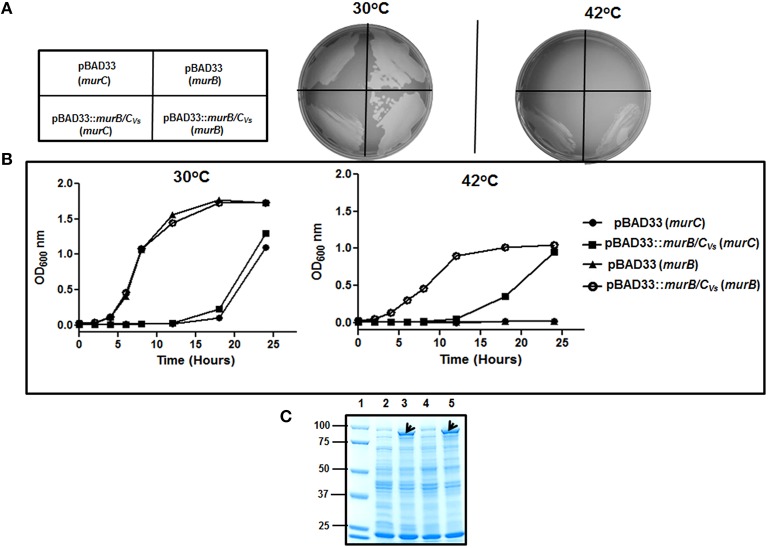
Functional complementation analysis of the E. coli murB and murC mutants. (A) Replica-plating experiment of the murC and murB mutants transformed with pBAD33 and pBAD33::murB/CVs grown at 30 and 42°C. (B) Analysis of the complementation experiment at 30 and 42°C in liquid culture assessing the growth phenotype by measurement of the optical density (OD) at 600 nm for a 24 h period. The growth experiments were done four times giving the similar growth profiles. The graphs in (B) represent one of those growth curves. (C) SDS-PAGE analysis of proteins from the complementation experiment to assess the expression of MurB/C in the mutant backgrounds. Lane (1), protein ladder (kDa). Lane (2), 10 μg of protein extract from the E. coli murC mutant harboring pBAD33 grown at 30°C. Lane (3), 10 μg of protein extract from the E. coli murC mutant harboring pBAD33::murB/CVsgrown at 42°C. Lane (4), 10 μg of protein extract from the E. coli murB mutant harboring pBAD33 grown at 30°C. Lane (5), 10 μg of protein extract from the E. coli murB mutant harboring pBAD33::murB/CVsgrown at 42°C. Crude extracts were obtained via sonication after 24 h from the samples grown at 30°C and 42°C. The black arrows show expression of the MurB/C recombinant enzyme. The proteins were resolved on a 10% (w/v) acrylamide gel and stained with Coomassie blue for visualization.